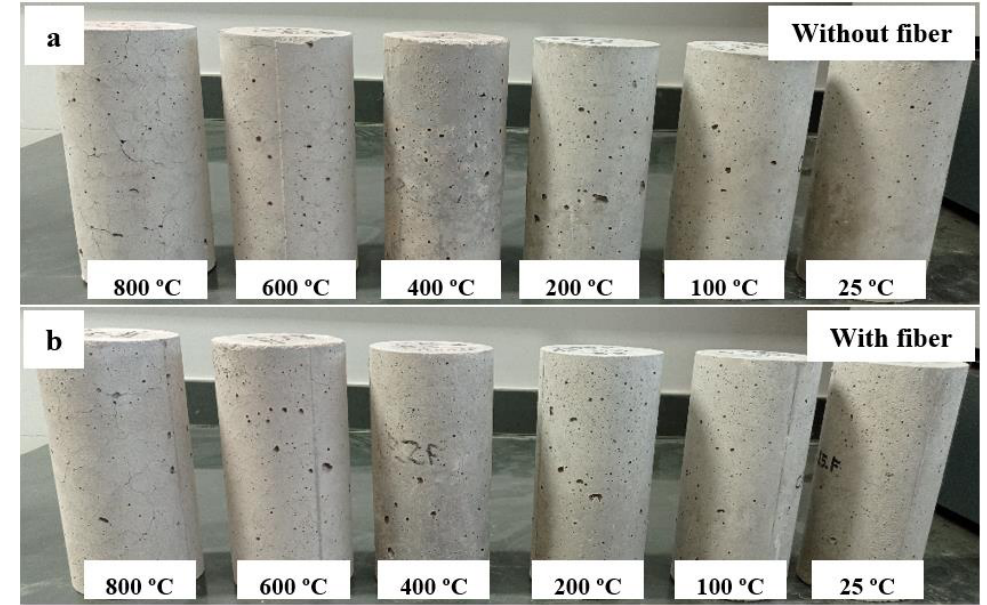
Figure 5. Specimen surfaces after heating test: ( a ) HSC-Ref and ( b ) HSC-PF.